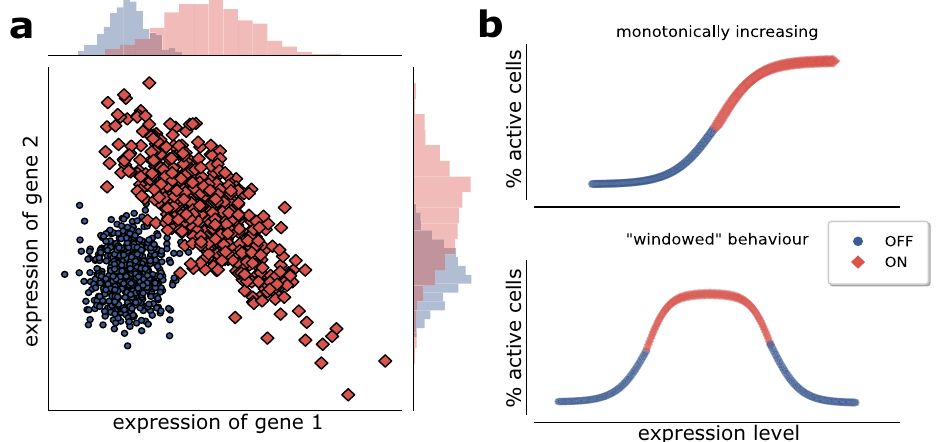
Figure 1. ( a ) A simple 2D ideal model in which single-feature classification performance fails in predicting higher-dimension classification performance. Both features ( gene expression 1 and gene expression 2 ) badly classify in 1D but have a very good performance in 2D. Moreover, the classification can be easily interpreted in terms of combined higher/lower expression of both probes. ( b ) Activity of a biological feature (e.g. a gene) as a function of its expression level: top—monotonically increasing, often also dichotomized to an on/off state; bottom—“windowed” behavior, in which the two activity states do not depend monotonically on expression levels. X axis: expression level, Y axis: biological state (arbitrary scales).